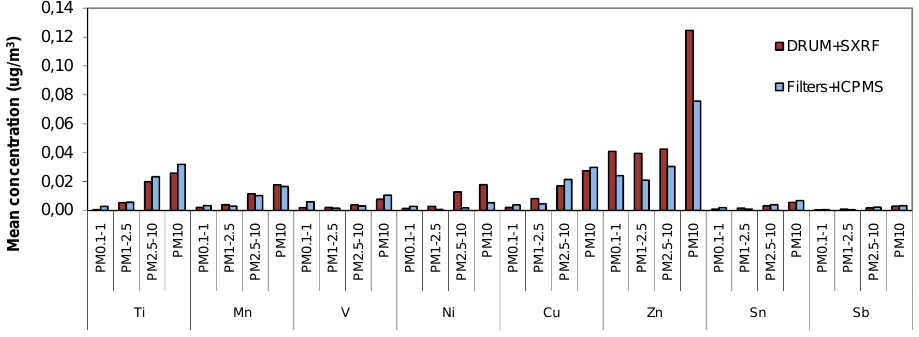
Fig. 2. Comparison of elemental concentrations obtained by ICP and SXRF techniques during the winter campaign at both BCN and MSY sites.